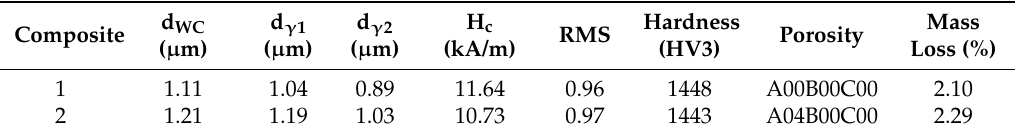
Table 1. Grain size and properties of sintered composites.